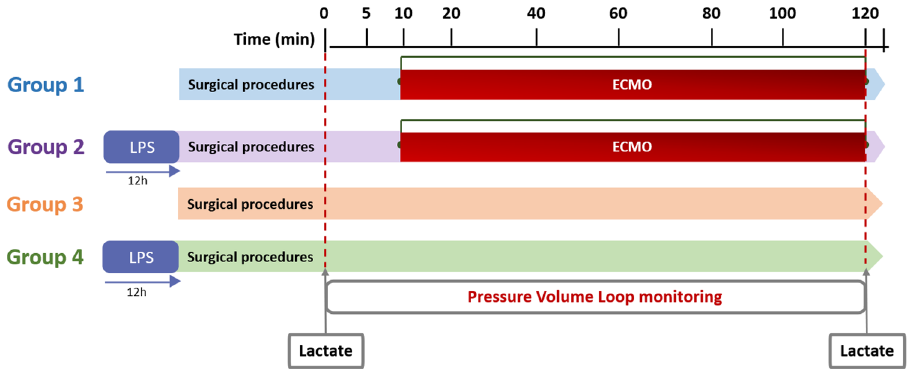
Figure 1. Experimental timetable in each group. Group 1 represents healthy rats with ECMO application. In this group, the PV loop was monitored during the ECMO application. Group 2 represents rats with LPS injection and ECMO application after 12 h. In this group, the PV loop was monitored during the ECMO application. Group 3 represents healthy controls with PV loop monitoring and Group 4 represents septic rat controls with PV loop